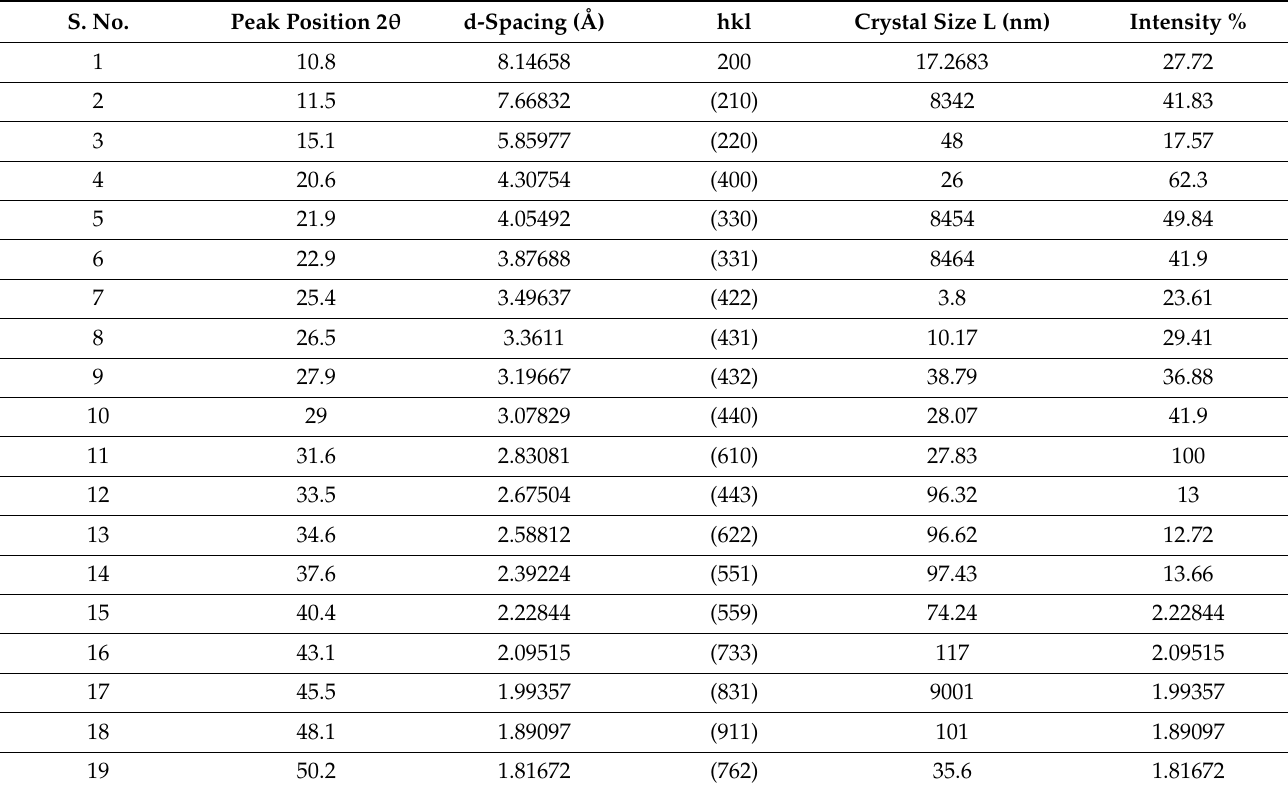
Figure 6. XRD analysis of biosynthesis: nanocellulose ( a ) and Ulva/Ag/cellulose nanocomposites ( b ) derived from U. lactuca . Table 2. Simple peak indexing of Ulva/nanocellulose and Ulva/Ag/cellulose nanocomposites.